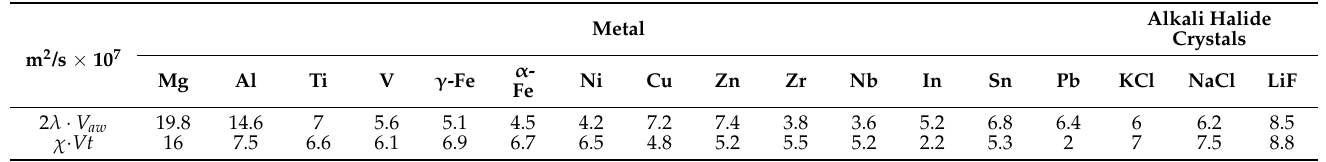
Table 2. Data for verification of strain invariant (13).